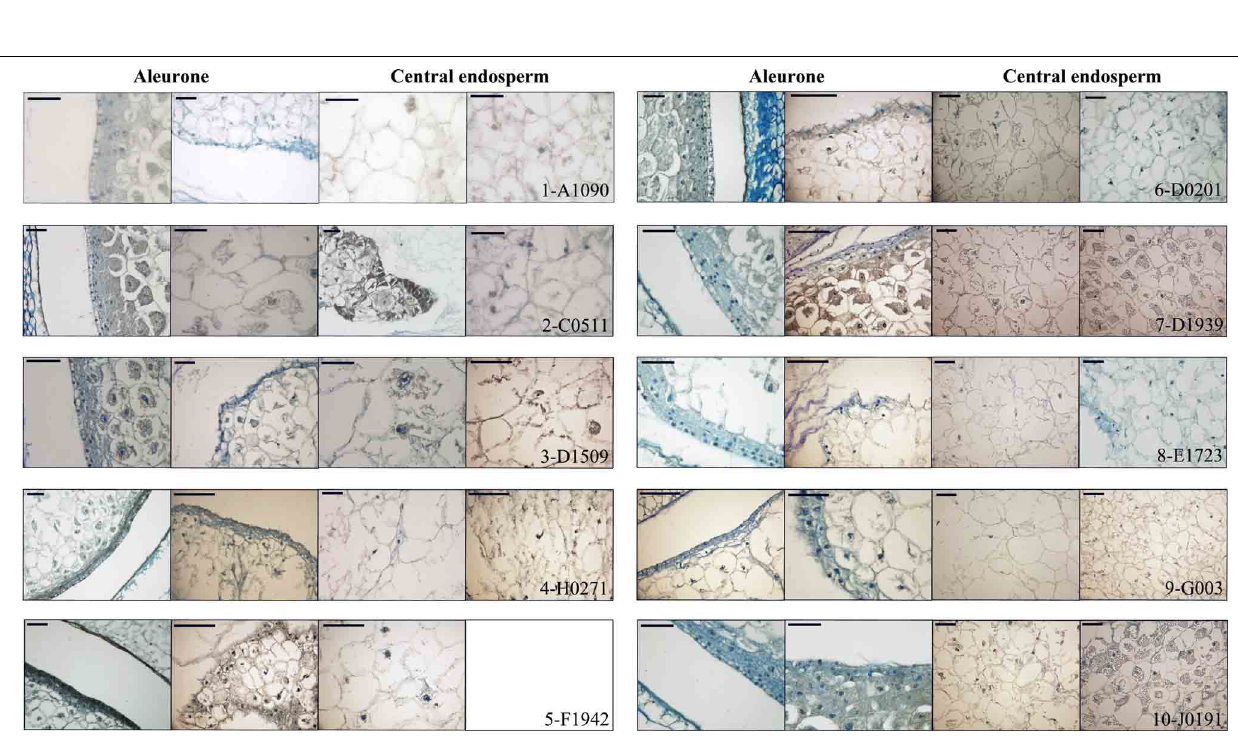
with azure B. Scale bars represent 50 µ m. Note that for line F1942 only one mutant image is shown, as the reduced endosperm size allows detailed visualization of central endosperm and aleurone in one